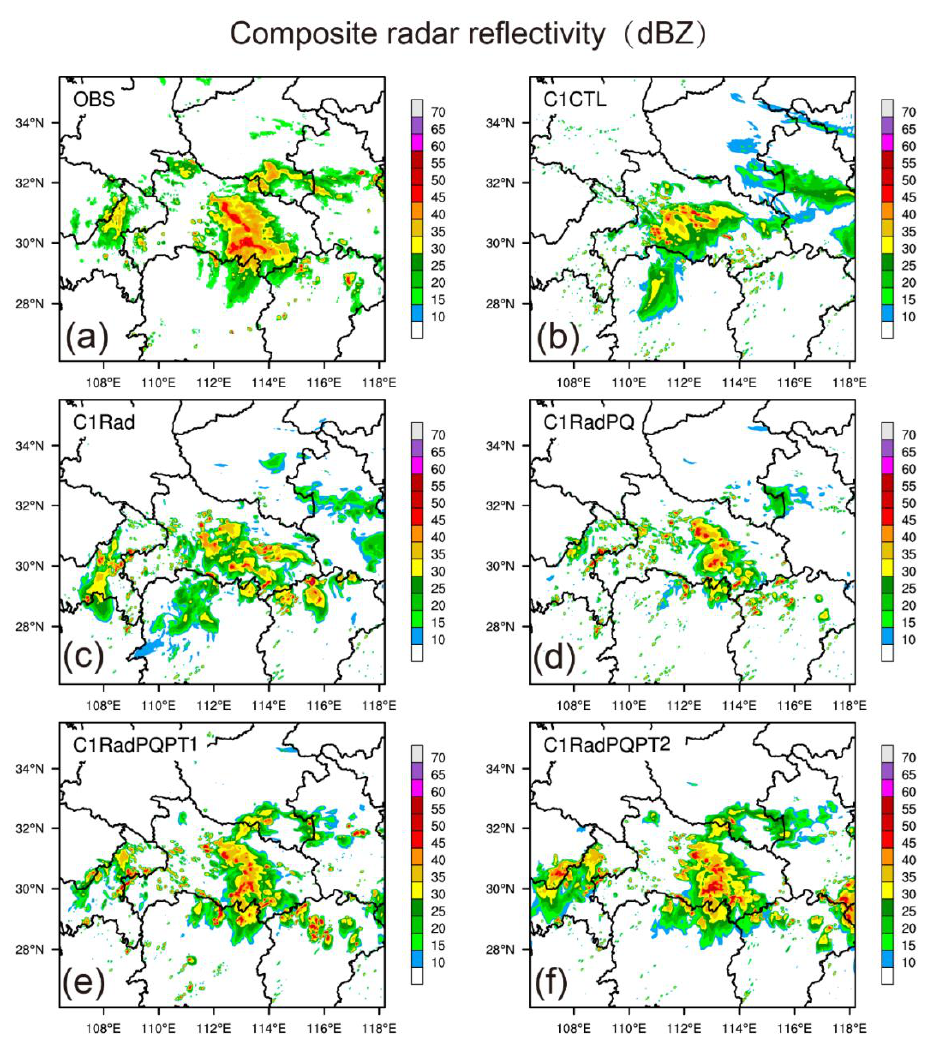
Figure 6. Composite radar reflectivity (dBZ) at 0400 UTC, 30 June 2018: ( a ) for SWAN mosaicked observations, one hour forecast for ( b ) C1CTL, ( c ) C1Rad, ( d ) C1RadPQ, ( e ) C1RadPQPT1, ( f ) C1RadPQPT2 experiments, respectively, launched from 0300 UTC.